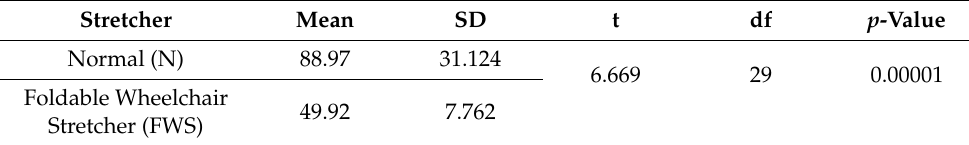
Table 15. Paired sample t -test for test